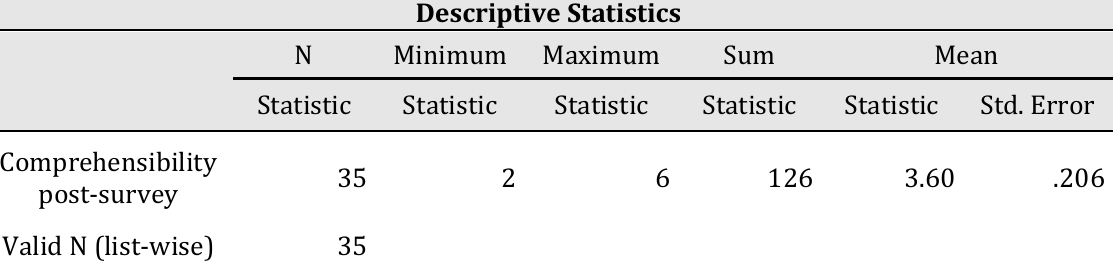
Table 18. Mean Point of Learners’ Comprehensibility